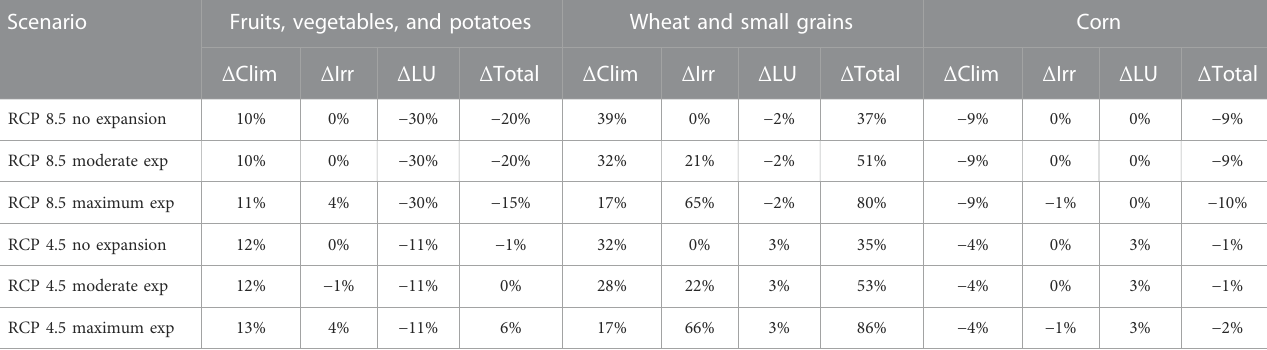
TABLE 2 Response of food crop production to climate change ( Δ Clim ), irrigation expansion ( Δ Irr ), and land-use change ( Δ LU ), normalized by the GCAM baseline scenario. Values do not re fl ect impact of curtailment on irrigated yields. Scenario Fruits, vegetables, and potatoes Wheat and small grains